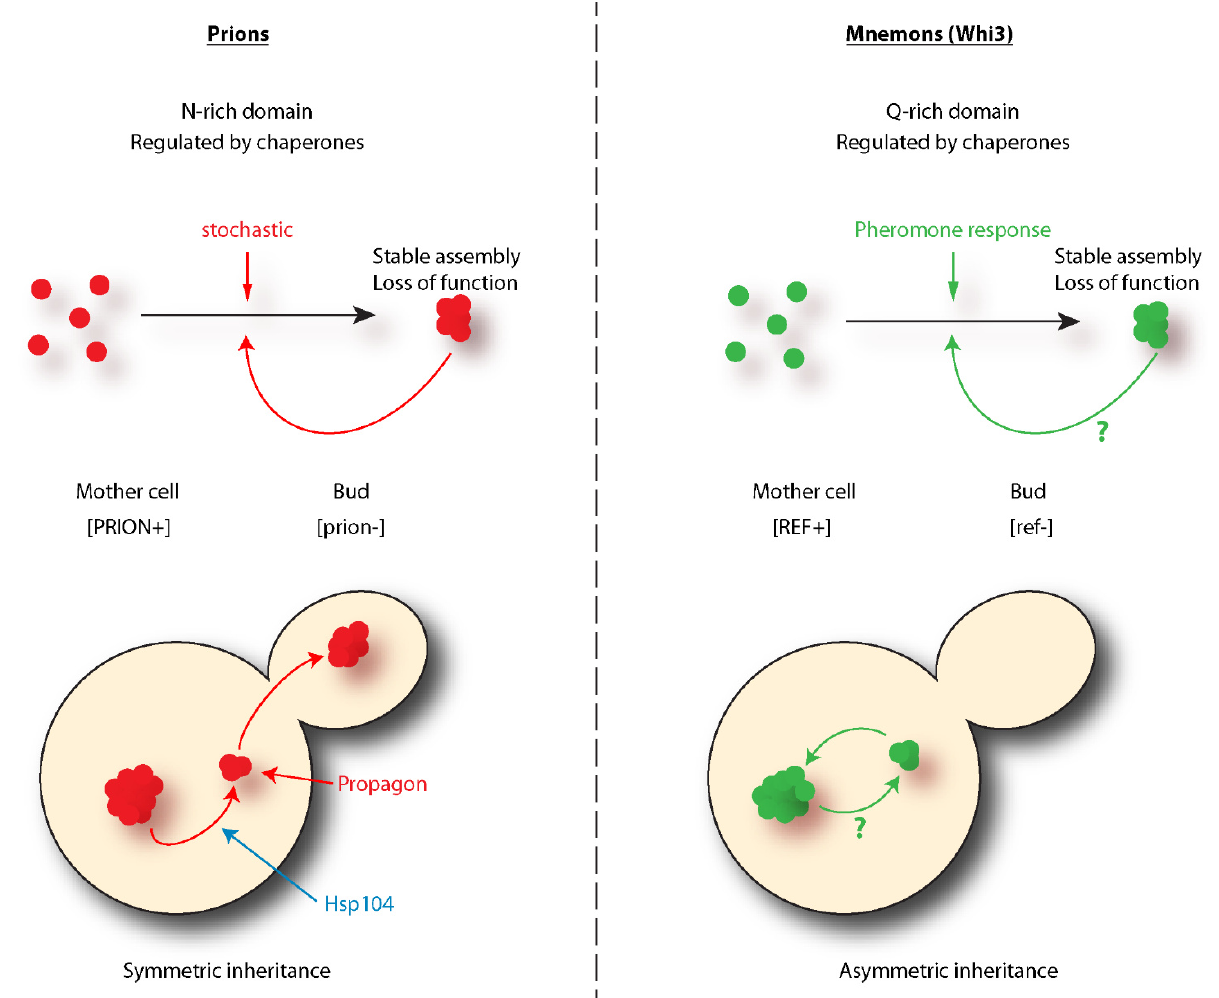
FIGURE 1: Mnemons differ from prions. Comparisons of some of the properties that are shared or unique to prions and mnemons. Note that the main differences lie in the mode of inheritance at mitosis and the induction of super-assemblies. [REF+] and [ref-] denote the pher- omone refractory state. Question marks highlight unknown parts of mnemons